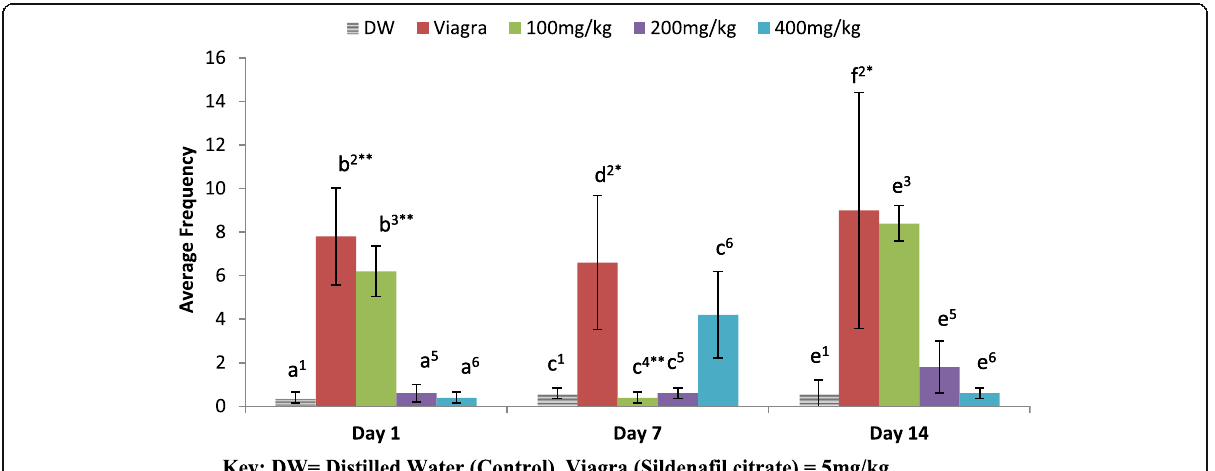
Fig. 1 Effect of ethanol extract of A. barbadensis root on mount frequency of male rats. Bars with dissimilar alphabets are significantly different from each other on each day. Bars with different numbers for the same dose group at different days are significantly different. All values are expressed as Mean ± SEM; n = 5;** P < 0.01; * P <